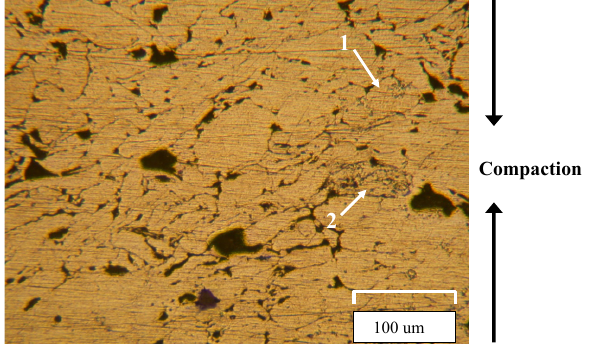
Figure 13. Optical micrograph of P/M AZ31 alloy sintered at 600 °C (500 MPa, 60 min, 375 °C). Arrows indicate light grey areas of frozen liquid phase inside porosity (1,